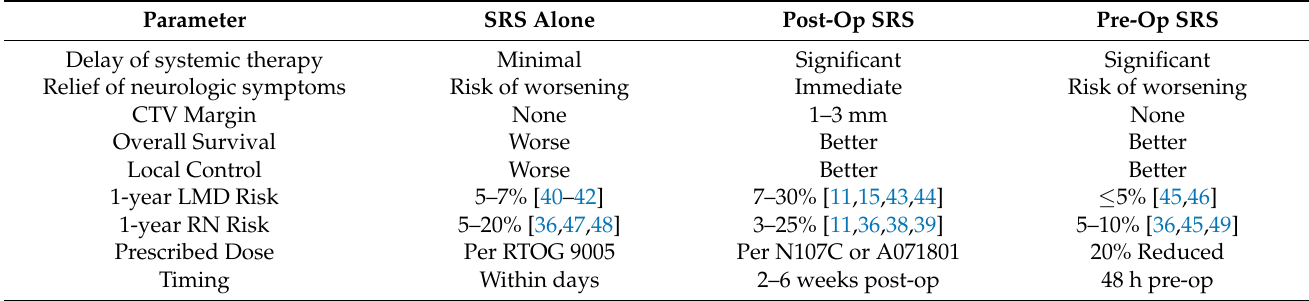
Table 1. Overview of the comparative advantages and disadvantages of SRS alone, post-operative SRS, and pre-operative